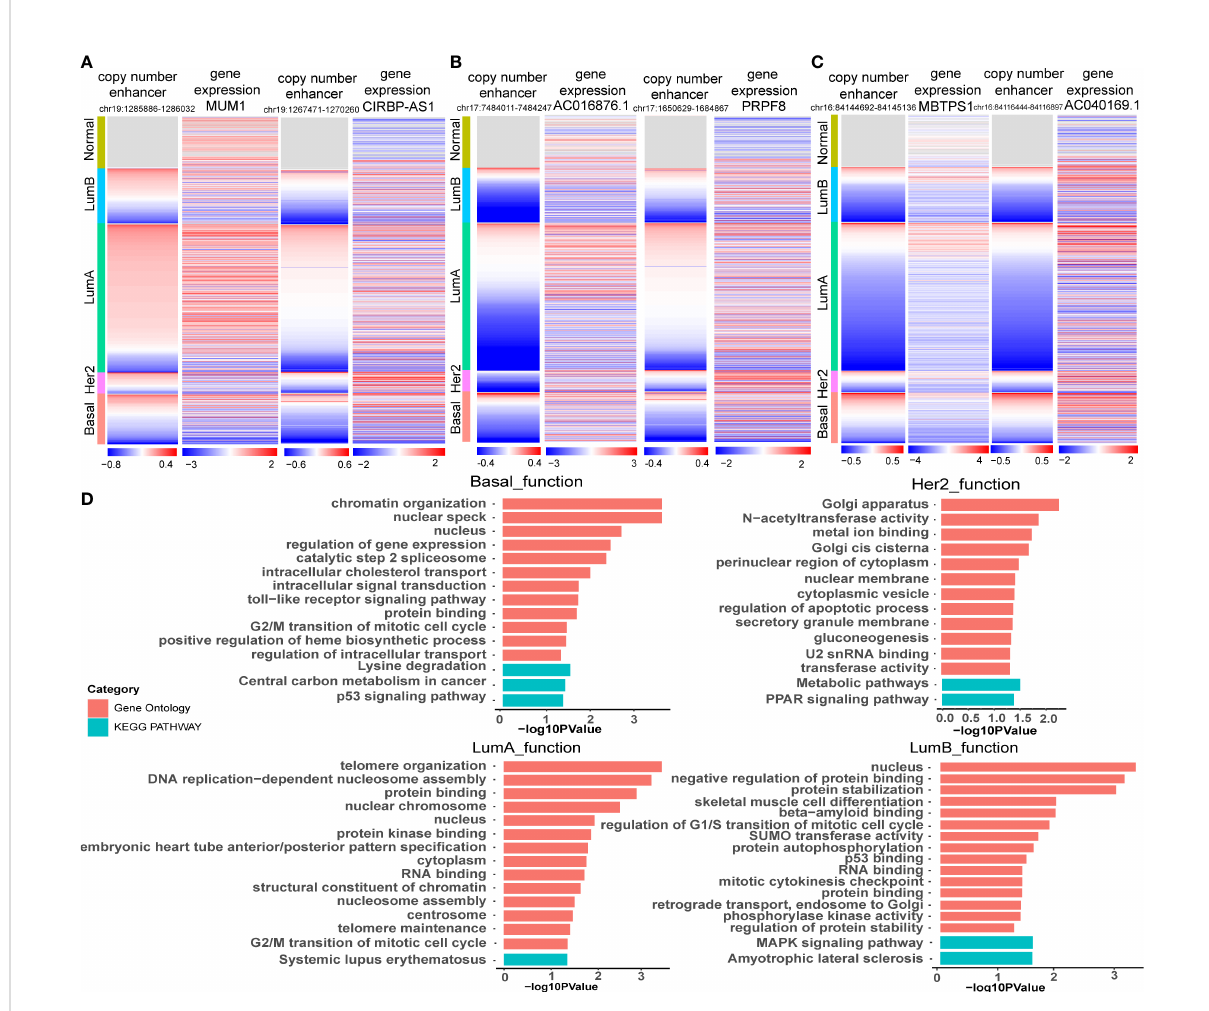
FIGURE 5 Functional enrichment analysis of target genes of CNA-driven enhancers in breast cancer subtypes. (A) Copy number variation of enhancers (chr19:1285886-1286032; chr19:1267471-1270260) and expression levels of MUM1 and CIRBP-AS1 in breast cancer samples. (B) Copy number variation of enhancers (chr17:7484011-7484247; chr17:1650629-1684867) and expression levels of AC016876.1 and PRPF8 in breast cancer samples. (C) Copy number variation of enhancers (chr16:84144692-84145136; chr16:84116444-84116897) and expression levels of MBTPS1 and AC040169.1 in breast cancer samples. (D) GO function and KEGG pathway analysis for key genes in the CNA-driven enhancer-lncRNA-mRNA network in Basal-like, her2, LumA and LumB subtypes of breast cancer using DAVID. The signi fi cance threshold was FDR less than